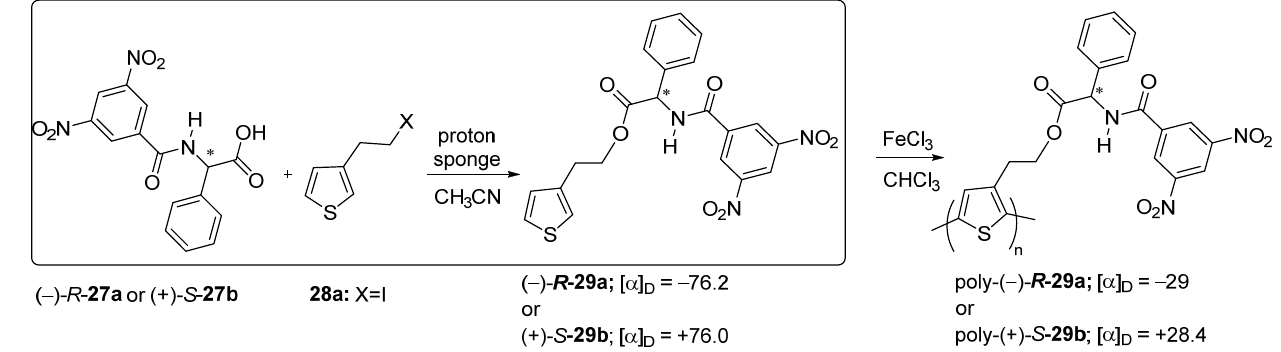
Scheme 8. Synthesis of the monomers of thienyl phenylglycinate 29a and 29b and their polymerization. Several 3-substituted thiophenes (32a,b, 33a,b, 34b), wherein thiophene rings are